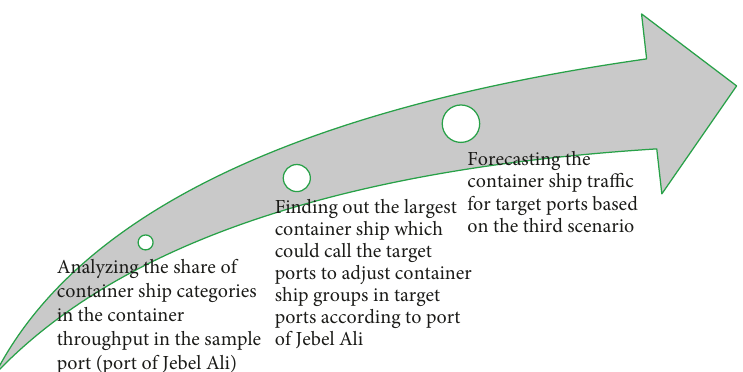
Figure 5: The procedure of forecasting container ship traffic in the third scenario.